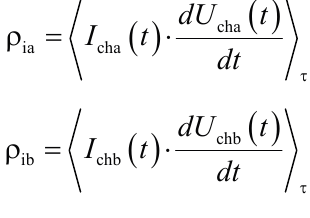
Figure 6. The voltage waveforms at Alice’s side, distributed element models, respectively, for a 1000 m cable, at ( a )  = 0.8; ( b )  = 8; ( c )  =